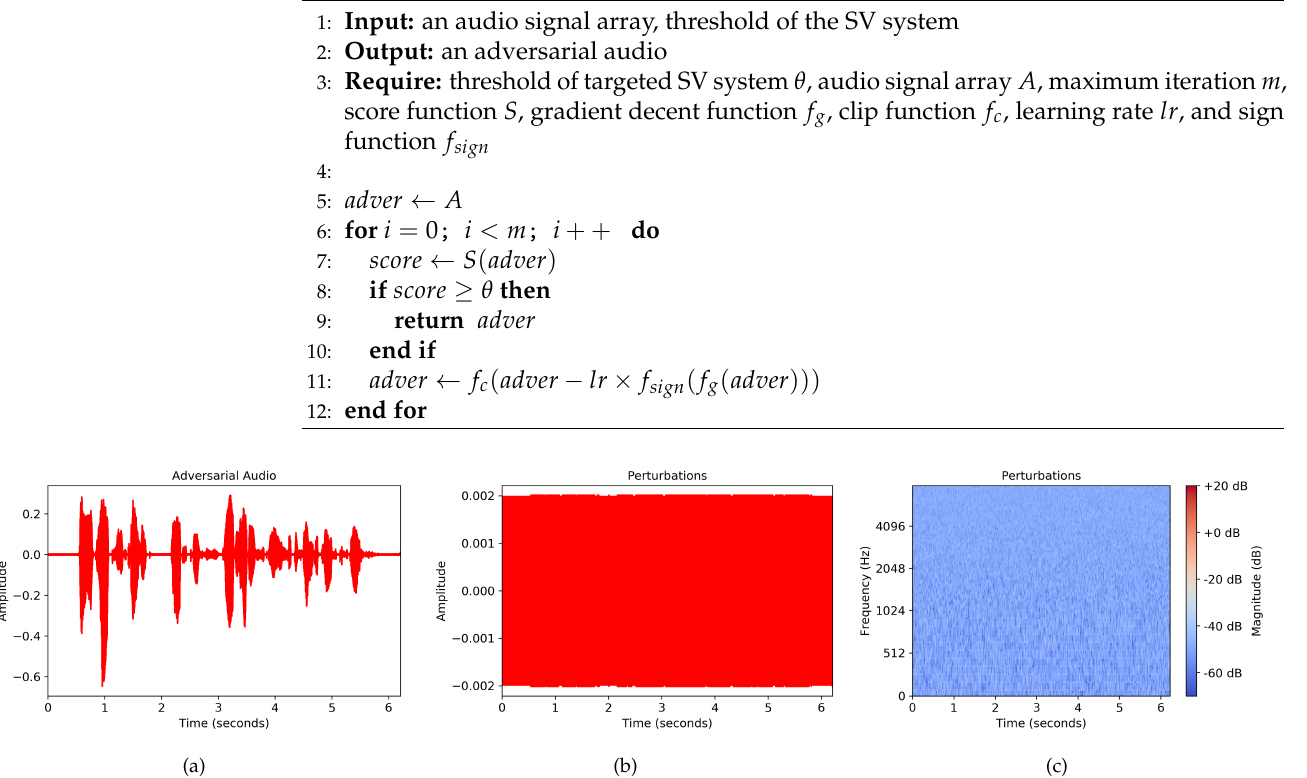
Algorithm 1 FakeBob Attacks